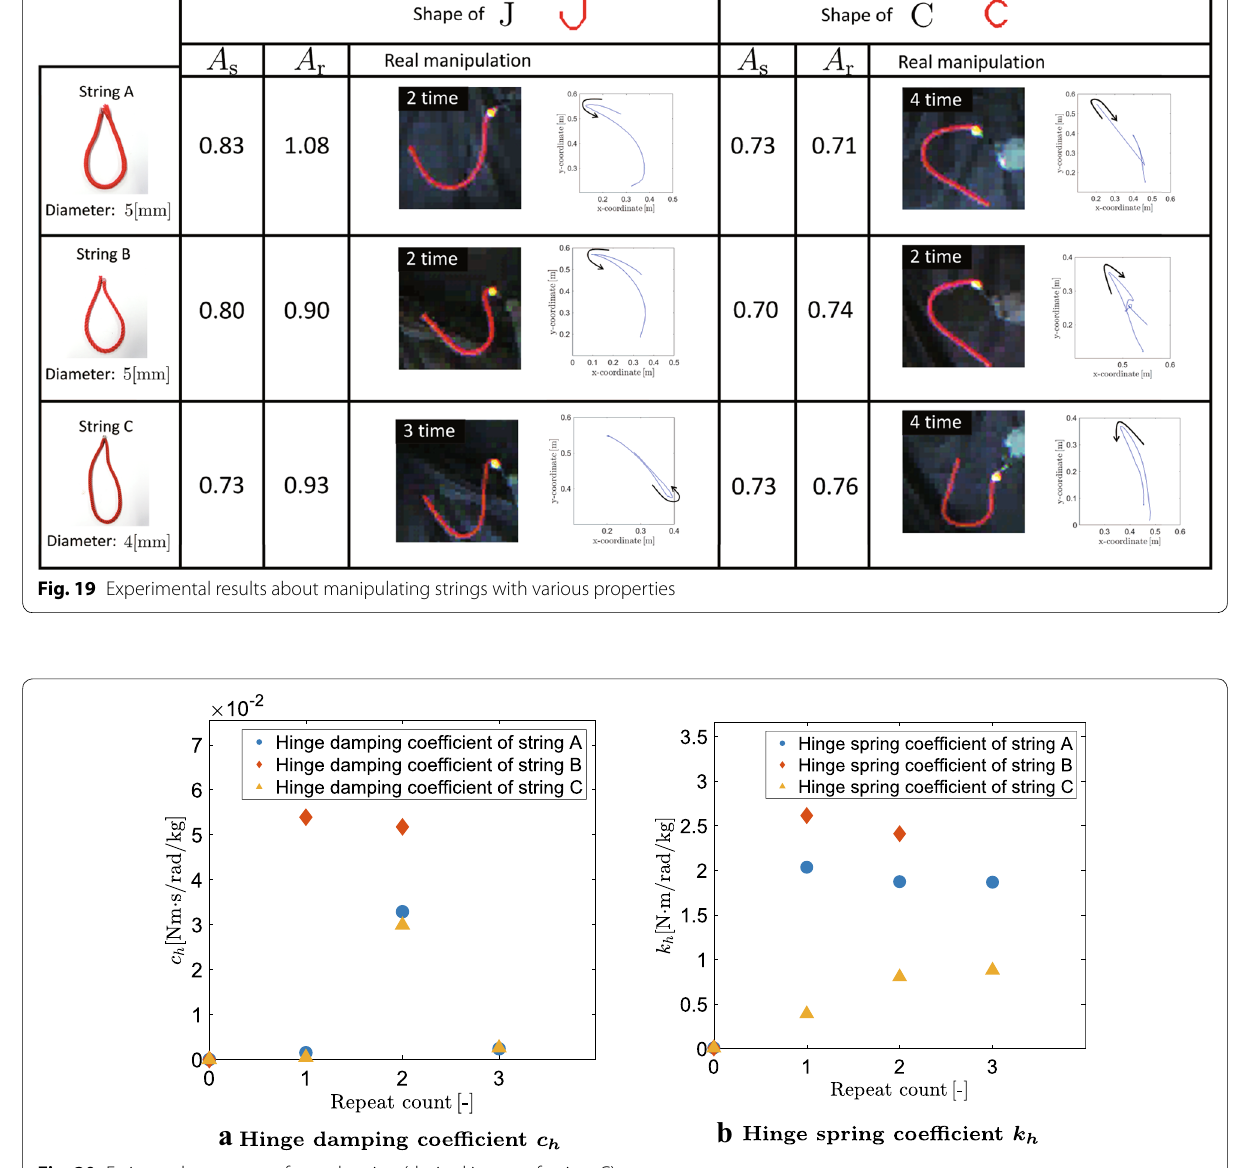
Fig. 20 Estimated parameters for each string (desired image of string: